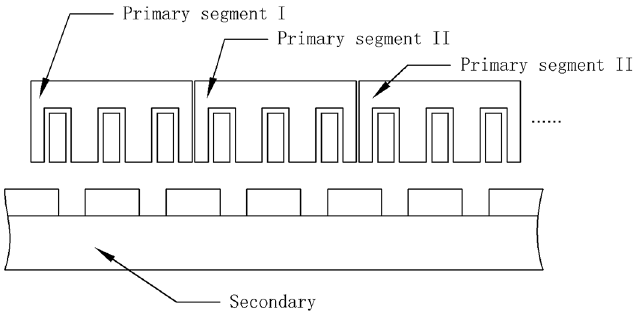
Figure 1. Segmented structure topology for FL the permanent-magnet linear generator.